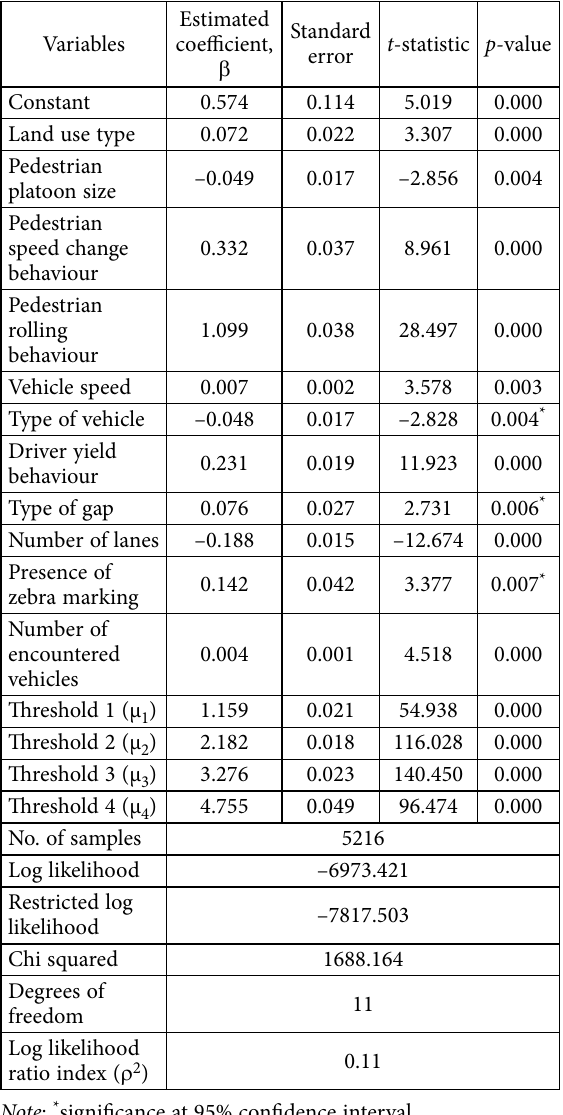
Table 4. Ordered probit model results of pedestrian QOS